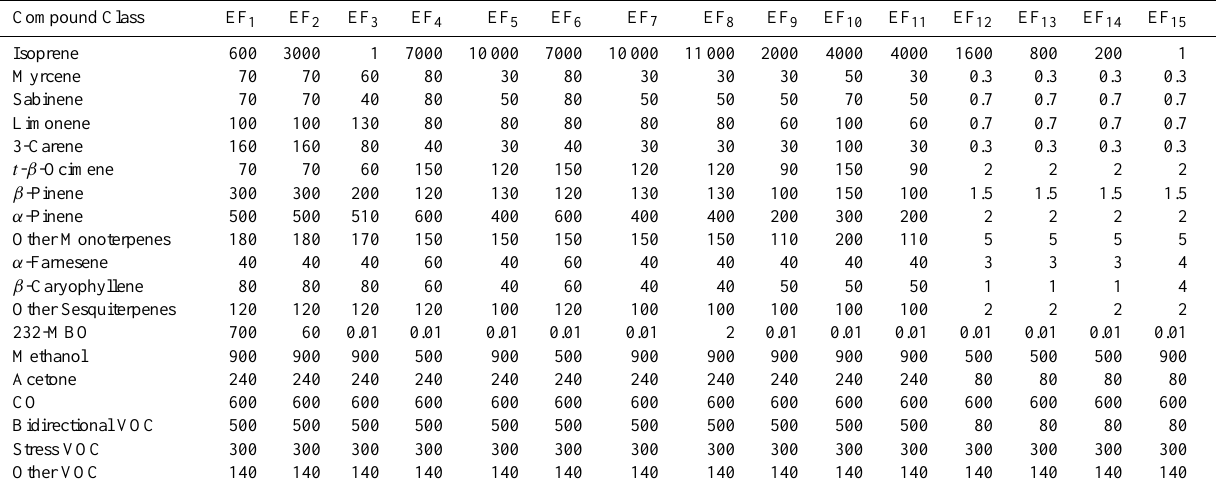
Table 2. MEGAN2.1 biogenic emission classes and emission factors (µgm − 2 h − 1 ) for each of the plant functional types described in Table